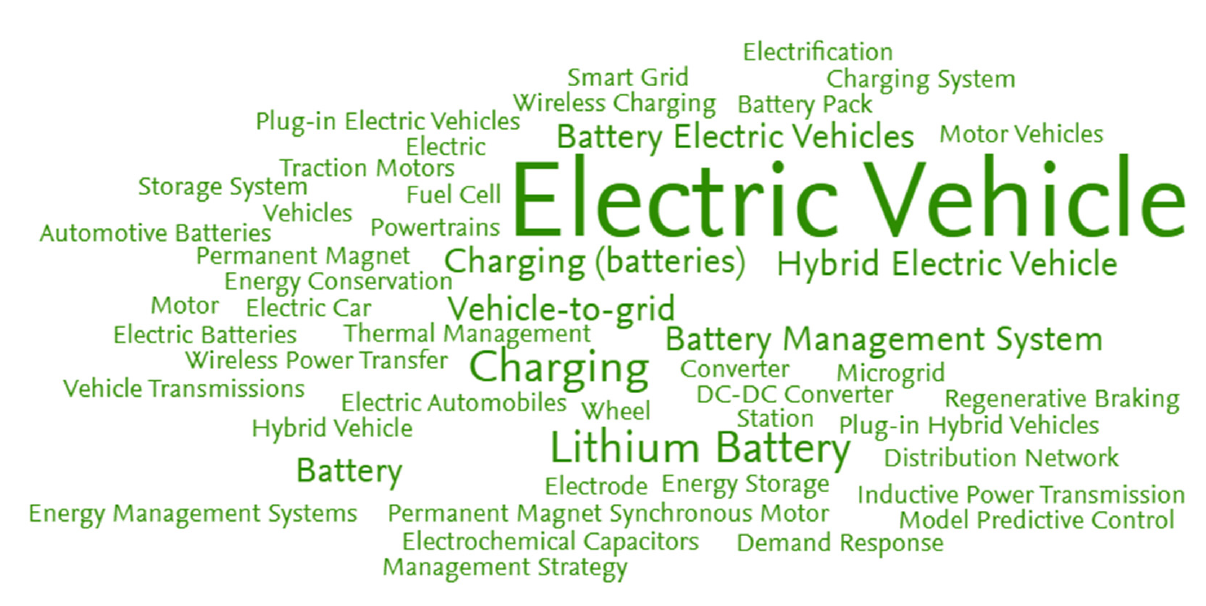
Figure 3. Key phrases based on XEV publications in 2021.